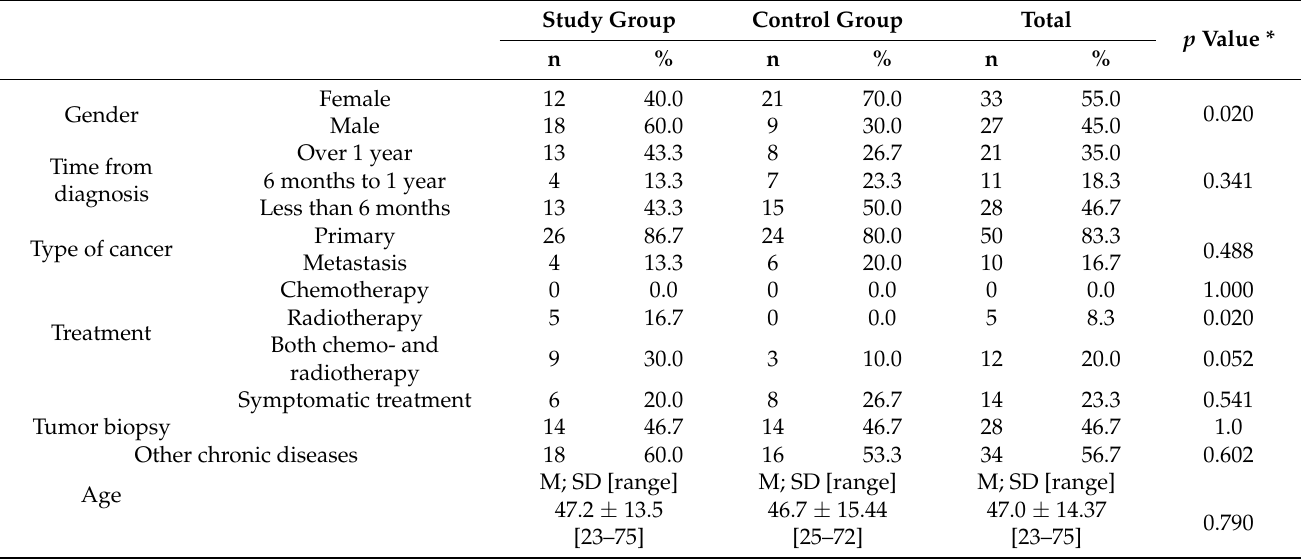
Table 1. Demographic and clinical data of the study participants.